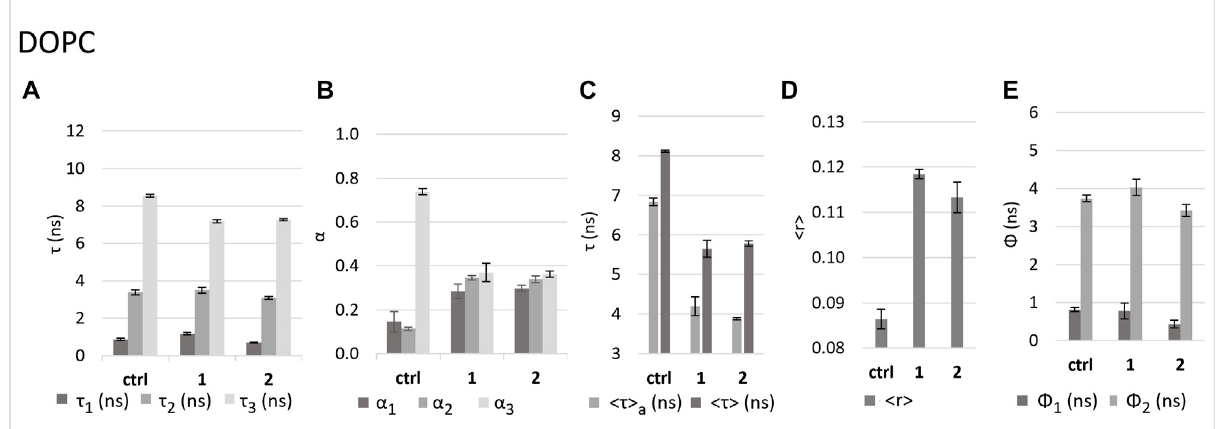
FIGURE 6 Effect of the complexes on DOPC LUVs as reported by DPH fl uorescence properties. Values in the absence (control - ctrl) and presence of complexes 1 and 2 in buffer 3 of (A) fl uorescence decay lifetime components τ 1 , τ 2 , and τ 3 ; (B) amplitudes associated with each component;